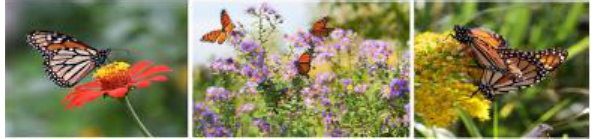
Figure 2. Working principle of BOA[51]